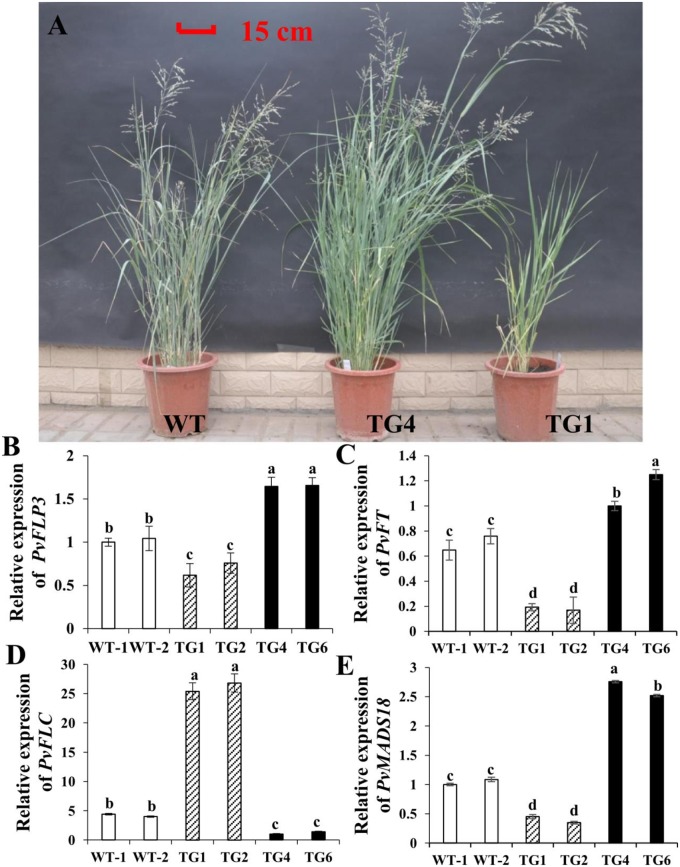
LpP5CS regulates growth and development in switchgrass.(A) Morphological characterization of transgenic switchgrass lines (5 months) overexpressing LpP5CS. (B-E) Relative expression levels of PvFLP3, PvFT, PvFLC and PvMADS18 in transgenic plants and WT plants. Value are mean ± SE (n = 6). Switchgrass Ubq1 was used as the reference for normalization. The significance of treatments was tested at the P < 0.05 level (one way ANOVA, Dunnett’s test). Leaf size is controlled by the complex coordination of cell division and expansion. To interpret the leaf size of group I, group II and WT plants, the leaf epidermal cells were viewed with scanning electron microscopy (SEM). The group II line (TG1) had a 36% reduction and the group I line (TG4) had a 43% increase in cell numbers compared with those of WT plants (Fig 3A–3C). We speculated that the increase in cell number was caused by increased expression of cell cycle-related genes. Thus, the expression level of cell cycle-related genes in TG1, TG4, and WT plants was analyzed. Cyclin-dependent kinases are the master regulators of the eukaryotic cell cycle to stimulate cell division and tissue growth. Therefore, we measured the expression level of the D-type cyclin gene (PvCYCD) (Pavir.J14518.1) and B-type cyclin gene (PvCYCB) (Pavir.J38704.1). The results showed that the expression levels of PvCYCD and PvCYCB were significantly up-regulated in the TG4 plants and significantly down-regulated in the TG1 plants compared with those in WT plants (Fig 3D). Collectively, these findings indicate that proline is crucial to plant growth and development.